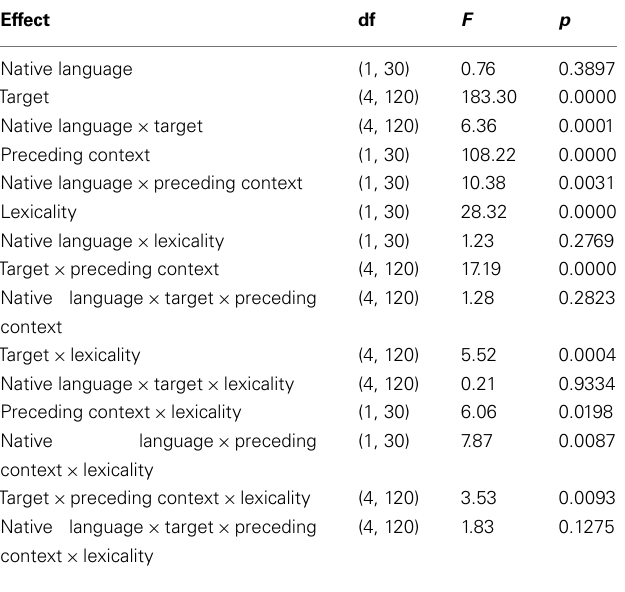
Table 2 |Analysis of variance table for Experiment